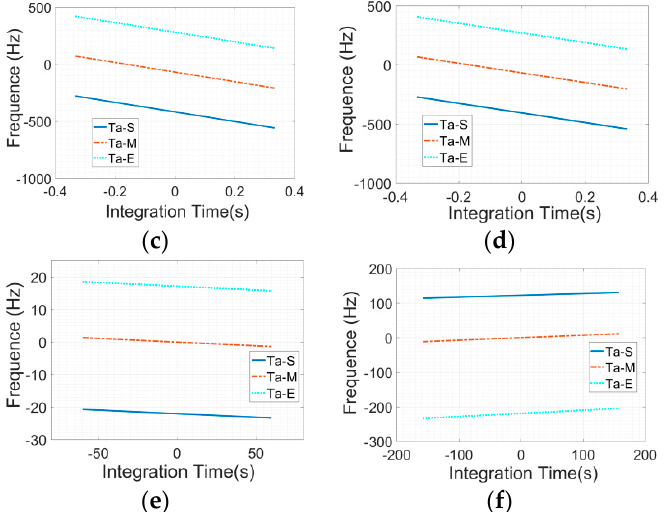
Figure 9. Staring mode Doppler history characteristics comparison between Geo-SAR and GF-3. ( a ) Doppler FM rate comparison between GF-3 and Geo-SAR. ( b ) P1(23.4°) and P2(75.7°) in nadir trace, and their positions comparison between GF-3 and Geo-SAR. ( c ) Doppler history, P1, GF-3. ( d ) Doppler history, P2, GF-3. ( e ) Doppler history, P1, Geo-SAR. ( f ) Doppler history, P2, Geo-SAR. Table 2. Doppler history comparison between GF-3 and Geo-SAR. Name